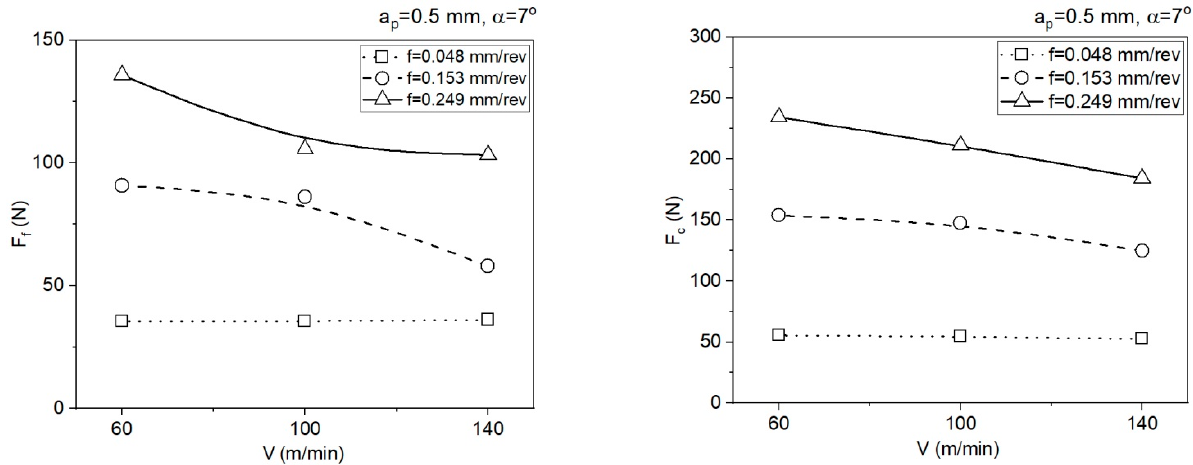
Figure 8. Impact of the cutting data on the values of the cutting force components F f and F c , a p = 0.5 mm, α = 7°.